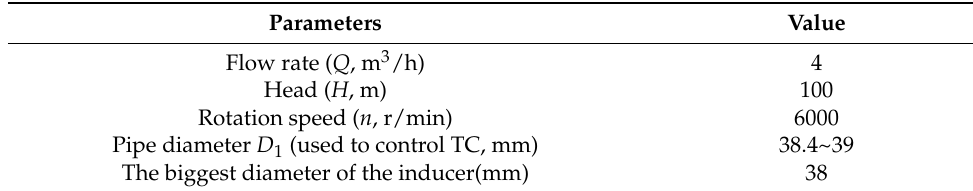
Table 1. Parameters of the